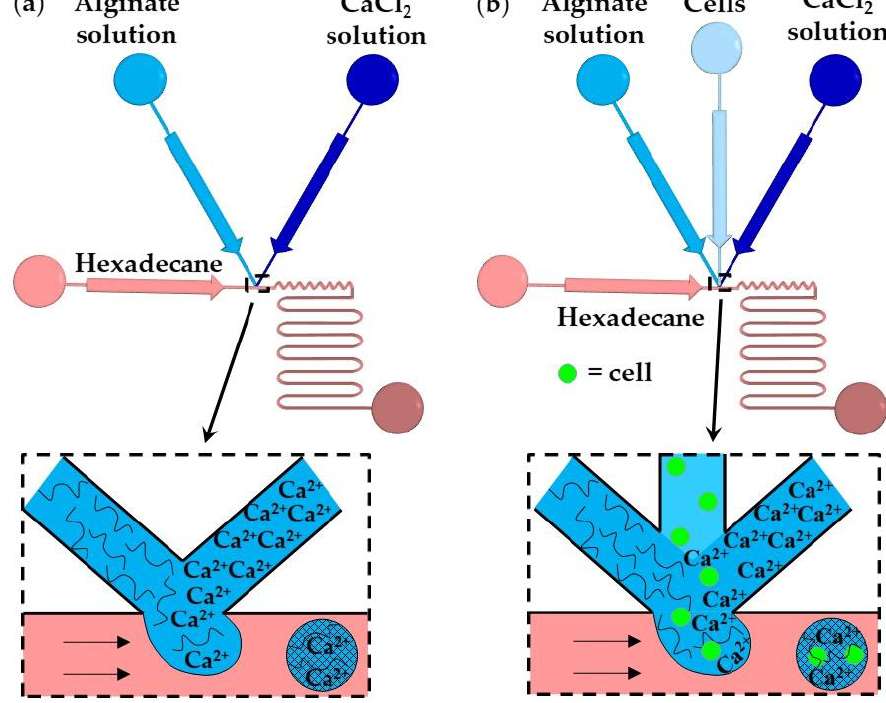
Figure 11. Formation of alginate beads by in-drop mixing [59]. ( a ) A microfluidic T-junction con- sisting of two converging inlet channels for supplying alginate and CaCl 2 solutions. ( b ) A micro- fluidic T-junction for cell encapsulation within a microgel consisting of three converging inlet channels